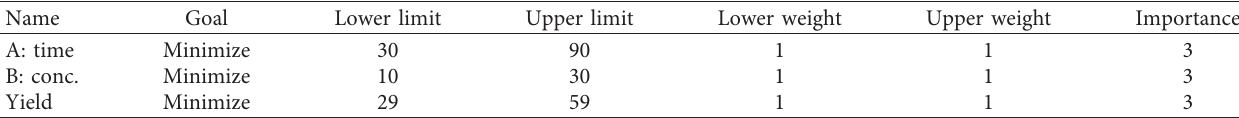
Table 6: Constraints of ethanol extraction yield.